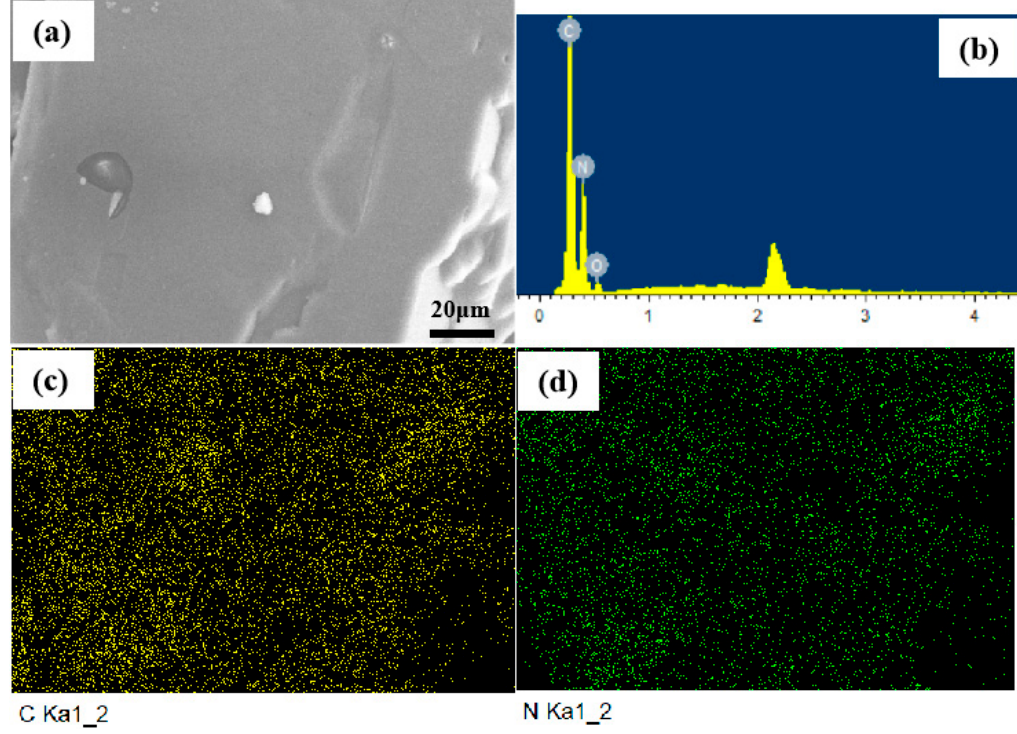
Figure 3. Elemental distribution of ATRZ. SEM image of ATRZ ( a ), the ratio of C and N elements ( b ), C element distribution ( c ) and N element distribution ( d